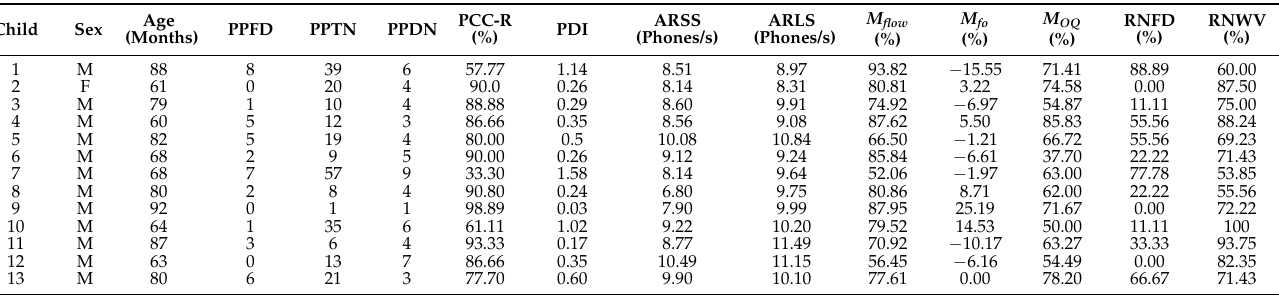
Table 3. Outcomes of an initial speech and language assessment and mean values of aerodynamic and EGG-based measures of children with